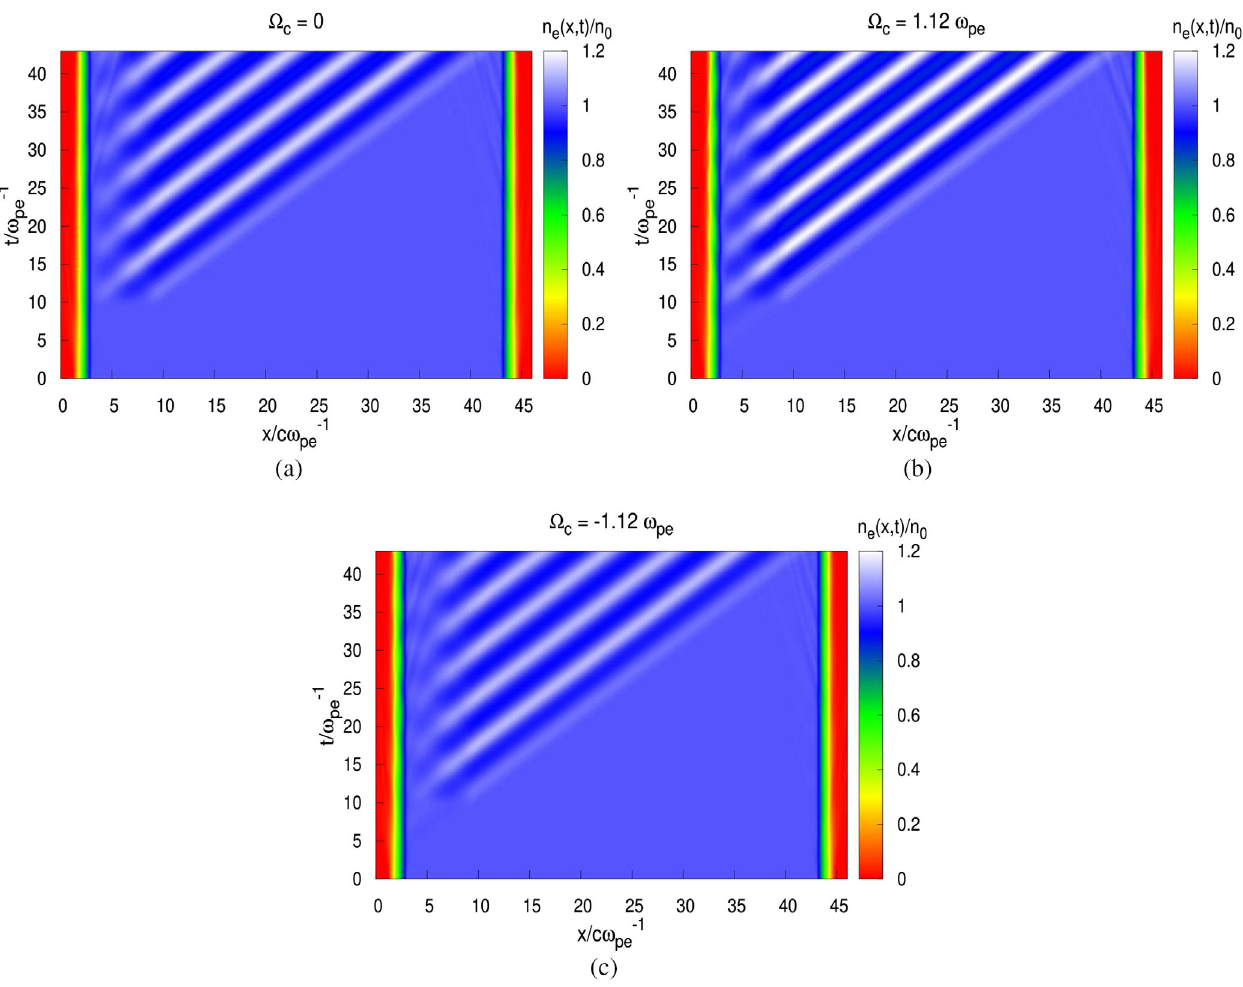
FIG. 6. Time evolution of electron plasma density profile n e ð x; t Þ in the ( x; t ) space. Plasma density fluctuations are created by propagation of RCP laser pulse through (a) nonmagnetized plasma slab Ω c ¼ 0 , (b) plasma slab which are embedded in an external magnetic field in positive x direction Ω c ¼ 1 . 12 ω and (c) plasma slab which are embedded in an external magnetic field in negative x pe direction Ω c ¼ − 1 . 12 ω pe Ω 0 [Fig. 6(a)], plasma slab embedded in an external c ¼ ˆ x magnetic field in positive x direction Ω c ¼ 1 . 12 ω pe ˆ x [Fig. 6(b)], and negative x direction Ω c ¼ − 1 . 12 ω pe